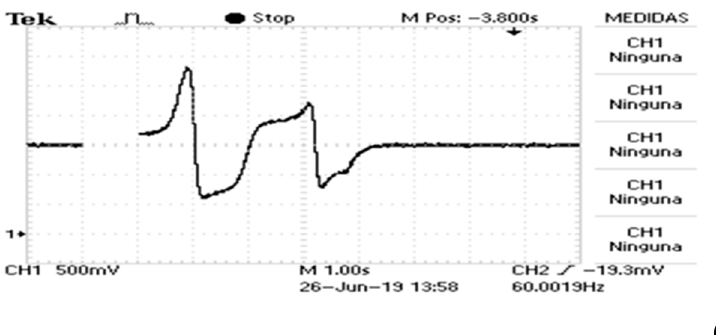
Figure 9. Time evolution of synchronization error signals by experimental results; ( a ) synchronization error of e 1 ( t ) = x s − x m ; ( b ) synchronization error of e 2 ( t ) = y s − y m ; ( c ) synchronization error of e 3 ( t ) = z s − z m .